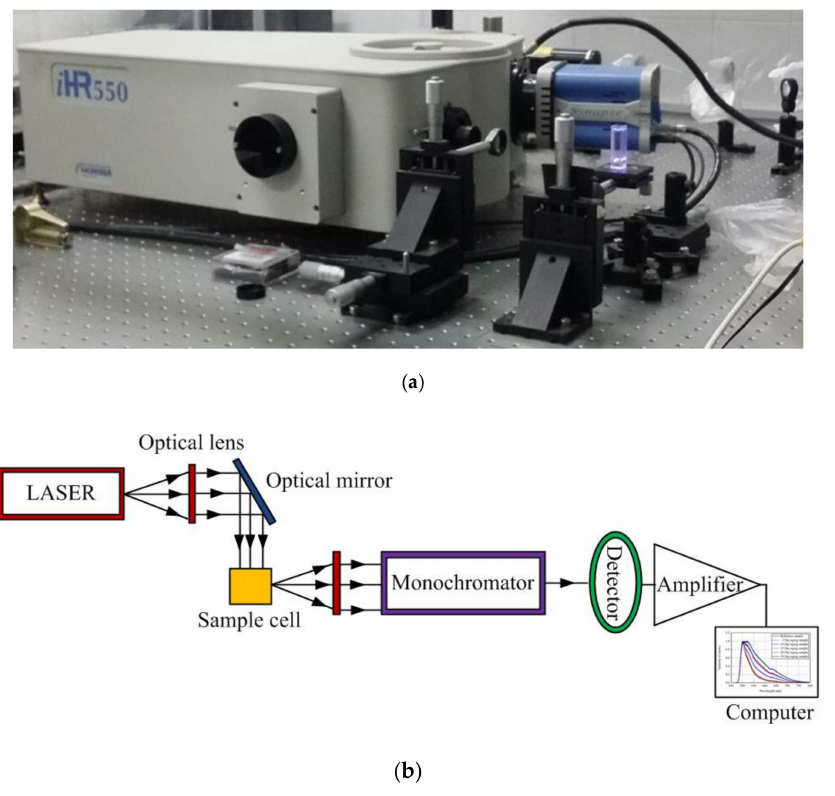
Figure 2. Experimental setup of photoluminescence spectroscopy: ( a ) Photoluminescence spectrome- ter setup and ( b ) configuration of photoluminescence